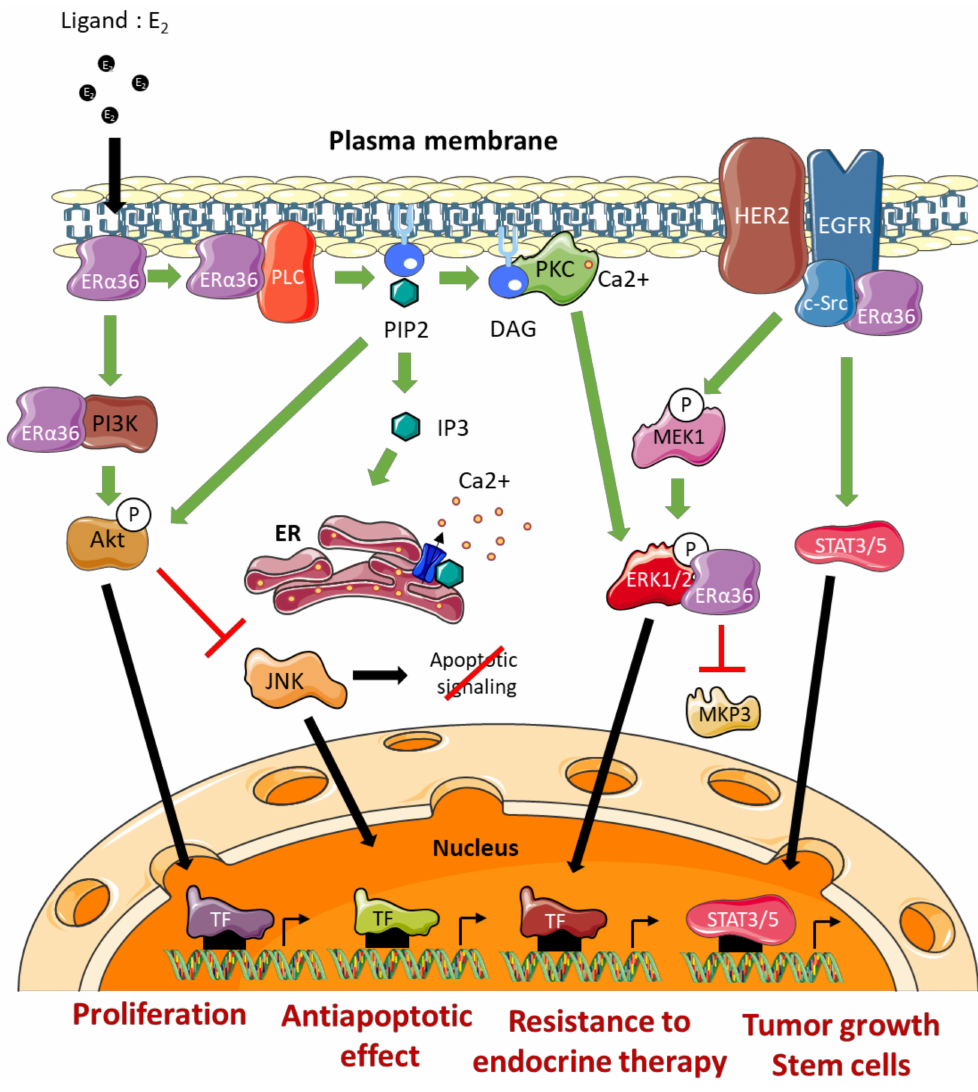
Figure 4. ER α 36-dependent non genomic pathways. DAG: Diacylglycerol, ERK: Extracellular signal-Regulated Kinase, TF: Transcription Factor, IP3: Inositol trisphosphate, JNK: c-Jun N-terminal Kinase, MEK: MAP / ERK Kinase, MKP3: MAP Kinase Phosphatase 3, PIP2: Phosphatidylinositol-4,5-bisphosphate, PKC: Protein Kinase C, PLC: Phospholipase C, ER: Endoplasmic Reticulum. The EGFR / Src / STAT3 / 5